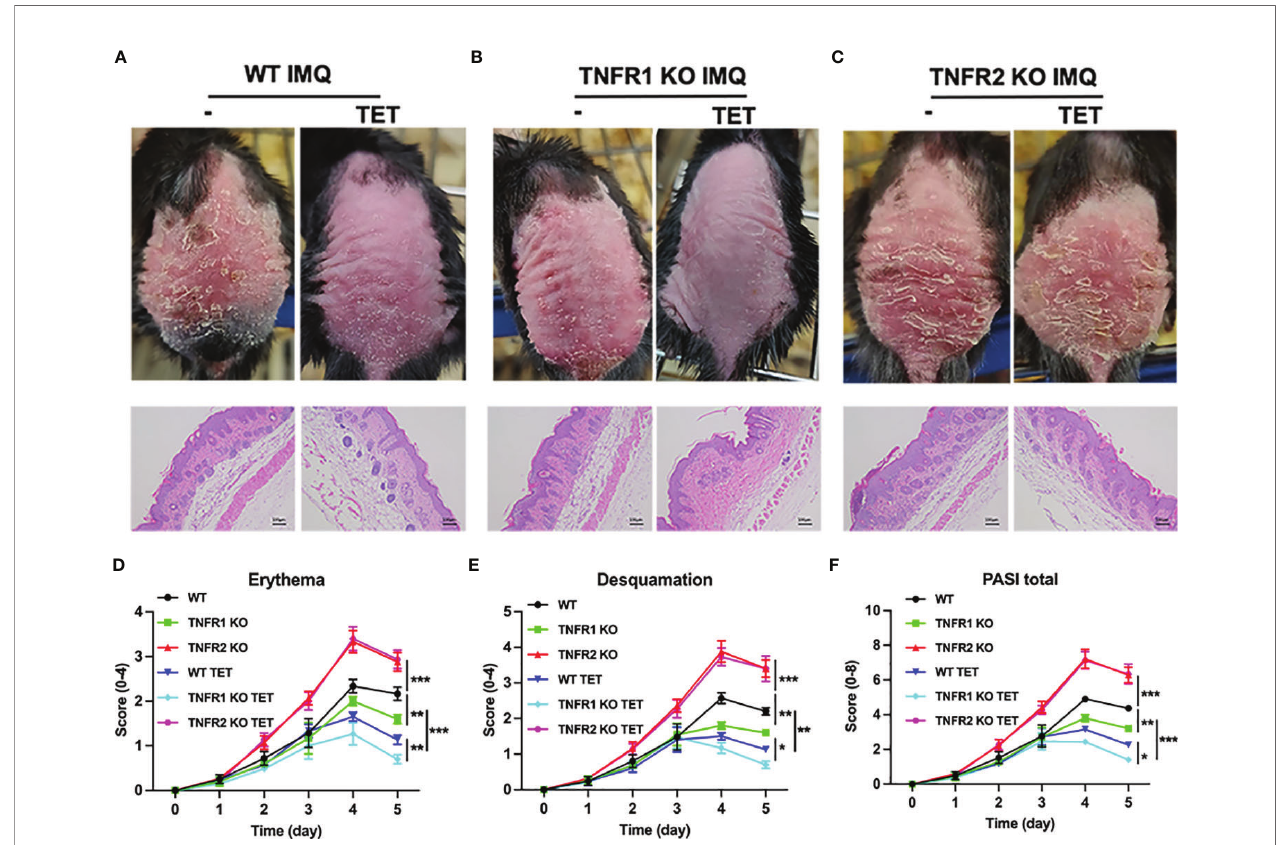
FIGURE 5 | TET NE reduces IMQ-induced psoriasis-like skin in fl ammation via TNFR2. WT, or TNFR1 -/- or TNFR2 -/- mice (N = 9) were treated with IMQ for 6 days. TET NE treatment starts from the second day after IMQ treatment for 5 days. 24 hours later, the mice were sacri fi ced. (A – C) Representative images of IMQ-induced psoriasis-like lesions and representative H&E staining of skin sections. (D – F) Clinical scores were assessed to monitor disease severity, including erythema (D) , desquamation (E) , and total PASI scores (F) . Data were shown as means ± SEM. * P < 0.05 ** P < 0.01, *** P <